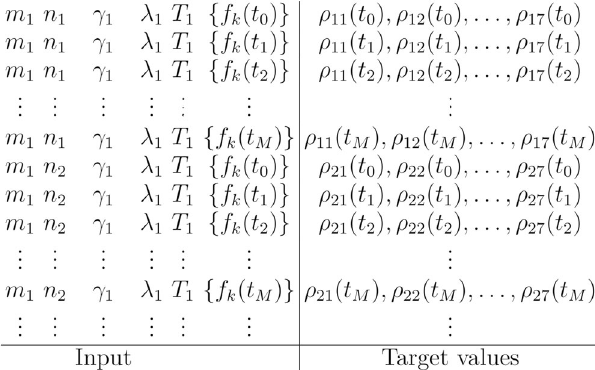
Fig. 1 Preparation of training data using parameters in AI-QD training (cid:8) (cid:9) is a set of time-functions based on the logistic framework. Here f k ð t Þ function f k ð t Þ ¼ 1 = ð 1 þ 15 (cid:3) exp ð(cid:2)ð t þ c k ÞÞÞ where c k = 5 k − 1.0 and k ∈ {0, 1, 2, … , 99} (see “ Methods ” ). Other parameters are t = { t t t … , t M }, λ = { λ λ λ … , λ i }, γ = { γ γ γ … , γ j }, and 0 , 1 , 2 , 1 , 2 , 3 , 1 , 2 , 3 , T = { T T T … , T n = { n n n … , n l }. In addition, labels 1 , 2 , 3 , 1 , 2 , 3 , 7 } are used for corresponding rows in the density matrix and labels for sites with possible initial excitation are m = { m 1 , m 2 }. As the off-diagonal elements ρ nq , n ≠ q are complex, we separate the real and imaginary